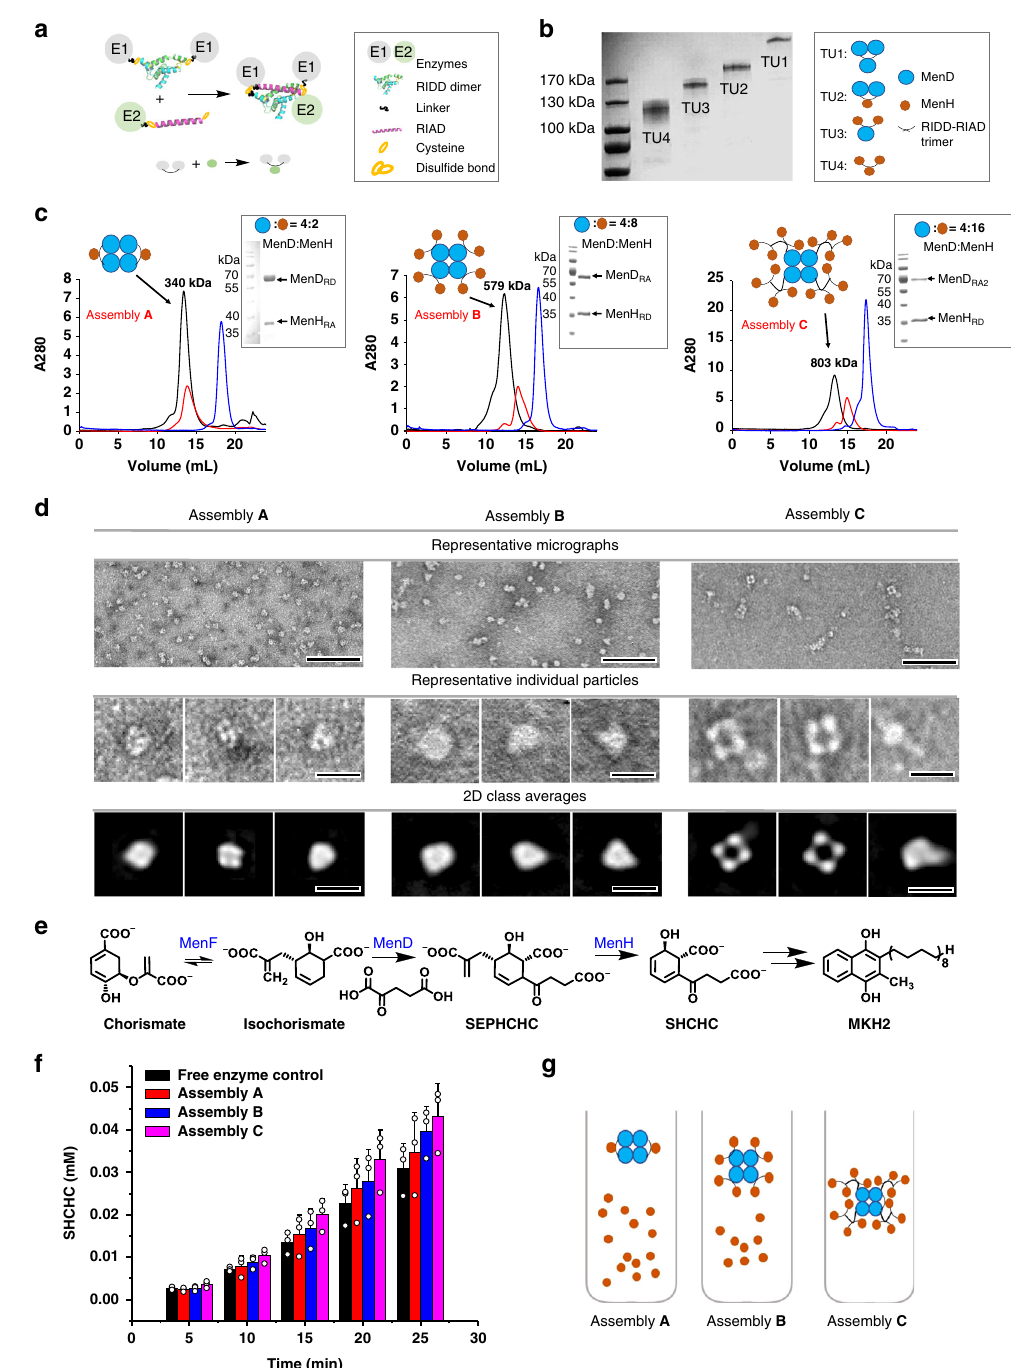
Fig. 1 Hierarchical MenD-MenH assemblies mediated by the RIAD – RIDD peptide interaction for biocatalysis. a The assembly of tri-enzyme units. E1, E2: enzymes; green and blue structure: RIDD dimer; black line: linker; pink structure: RIAD; one orange circle: cysteine; two orange circles: disul fi de bond. b Disul fi de-stabilized MenD-MenH tri-enzyme units resolved by SDS-PAGE. Blue fi lled circle: MenD; orange fi lled circle: MenH; black semilunar line: RIDD- RIAD trimer. c Hierarchical enzymes assemblies A, B, and C having different stoichiometries and sizes. Black line: assembly structure; red line: protomers of MenD; blue line: protomers of MenH. d Tetrameric structures of the assemblies on TEM. Scale bars: 100 nm (the fi rst row) and 20 nm (the second and third row). e MenD and MenH catalyzed conversion of isochorismate to SEPHCHC and then SHCHC. f Measurement of the cascade biocatalyst by product generation in three enzyme assembly systems. Red column: Free enzyme control; purple column: Assembly A; blue column: Assembly B; dark blue column: Assembly C. g Schematic diagram of Assembly A, B, and C. Error bars indicate the standard deviations of three biological replicates. Source data are provided as a Source Data fi